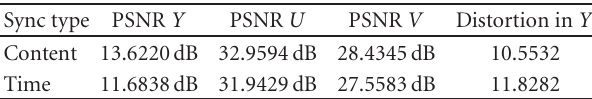
Table 4: Objective assessment results for a 5-minute video with di ff erent motion activity